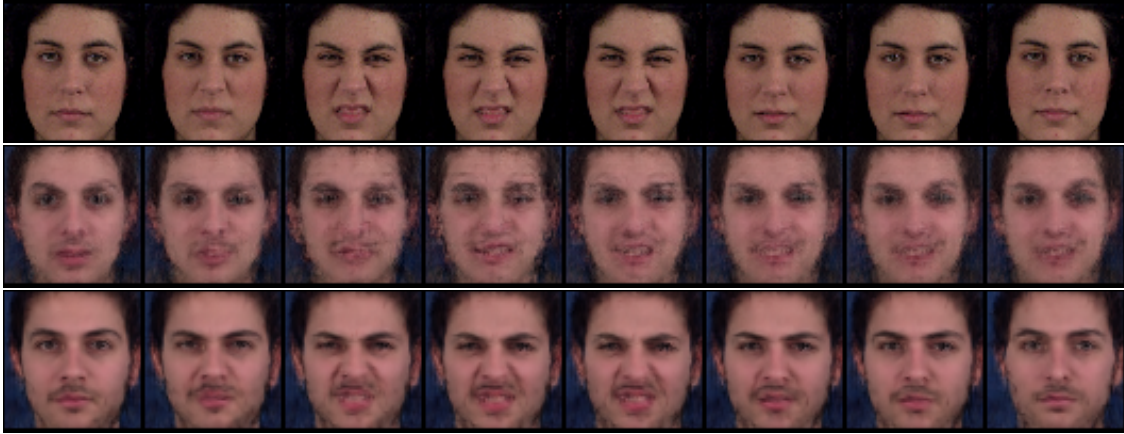
Figure 8. Example of zero-replaced generation on the MUG dataset. We fixed the dynamic variables and replaced the static variable with zero. The top, middle, and bottom rows denote the input video and the results using DSVAE and the proposed method,